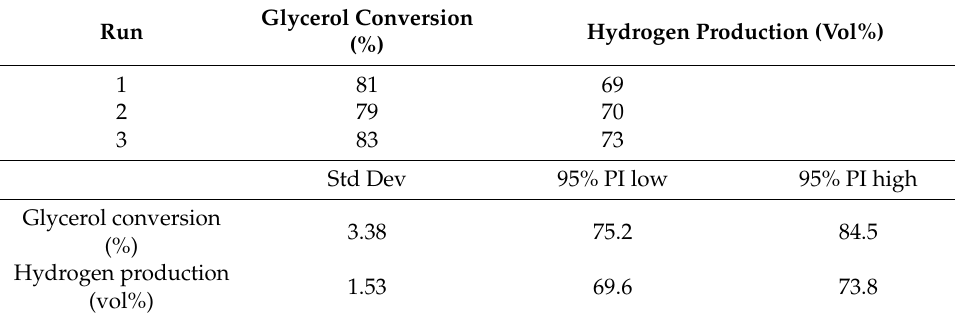
Table 5. Confirmation Post Analysis of Experimental